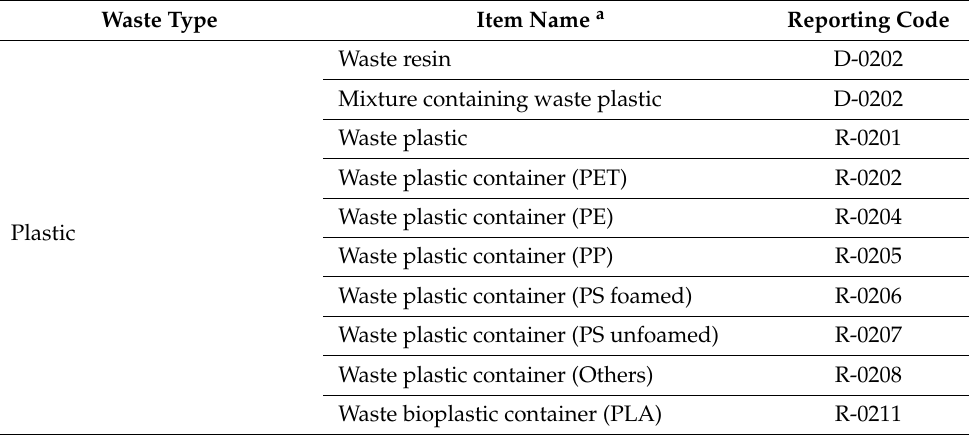
Table 2. Waste categories used as feedstocks for producing SRFs in